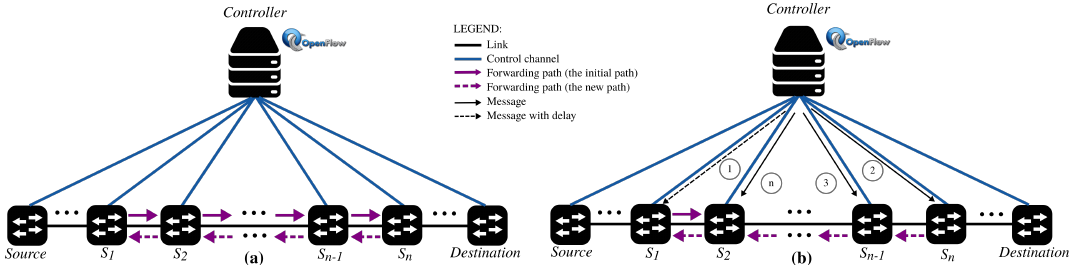
Figure 4. The generic Transient Forwarding Loop (TFL) scenario: ( a ) initial and final forwarding paths; ( b ) a sequence of messages to redirect a pflow from S n to S 1 ends with a